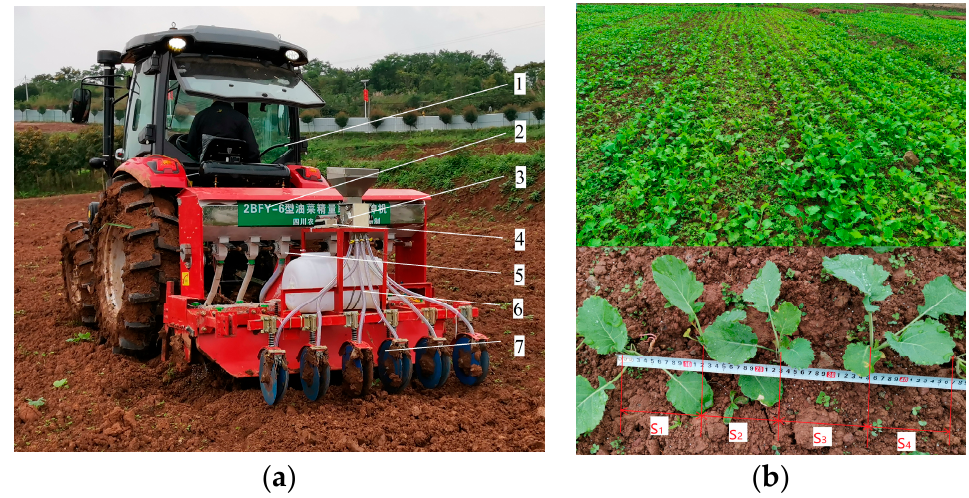
Figure 6. Field experiment of the rapeseed seeder ( a ) and seedling growth and measurement ( b ). Note: (1) tractor, (2) fertilizer box, (3) centralized seed-metering device, (4) controller, (5) fertilizer-metering device, (6) seed tube, and (7) double-disc opener.